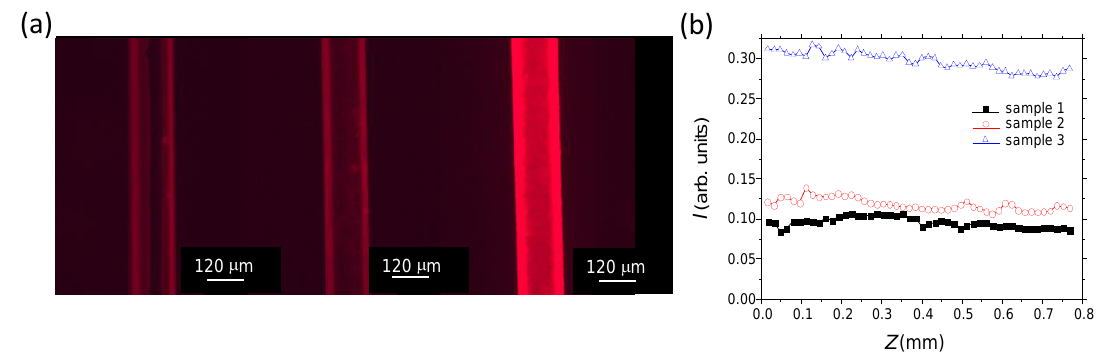
Figure 4. ( a ) Fluorescence image of Samples 1–3 (left to right) and ( b ) line intensities over the fibre core region (Sample 1, ■; Sample 2, ○ ; Sample 3, ∆